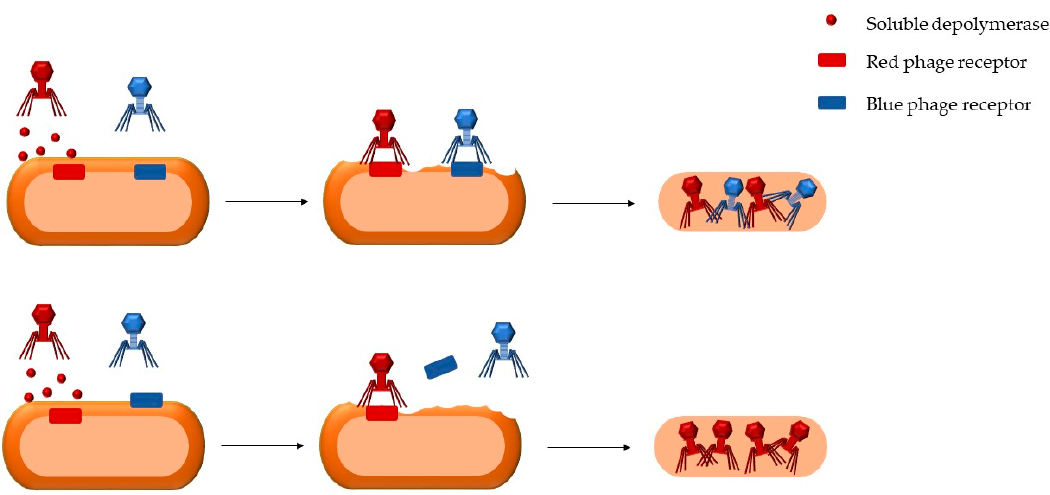
Figure 3. Hypothesized depolymerase-mediated phage-phage interactions. Soluble depolymerases should be shareable extracellular products allowing for synergistic or antagonistic interactions among phages. ( Top ) A depolymerase produced by the red phage digests the exopolysaccharide (EPS) capsule, exposing phage receptors attached to the cell membrane, but also exposing the blue receptor, which promotes entry of the blue phage. ( Bottom ) A depolymerase produced by the red phage digests the EPS capsule, exposing its receptor, but also releasing the blue receptor, which was embedded in the EPS capsule, thus blocking entrance of the blue phage.